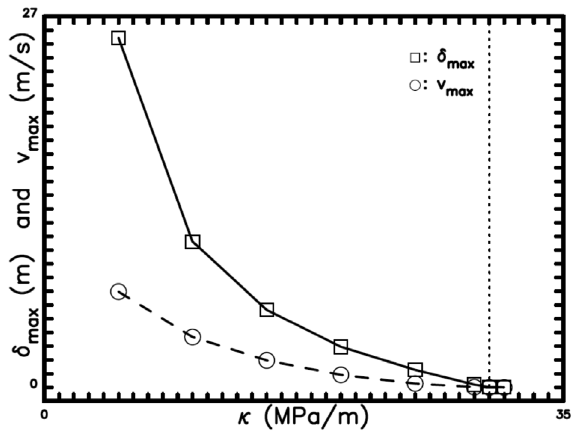
(solid line, open squares) and v Figure 4. Plots of d max line, open circles) versus l . The vertical dotted line displays the crit- ical state with l =30